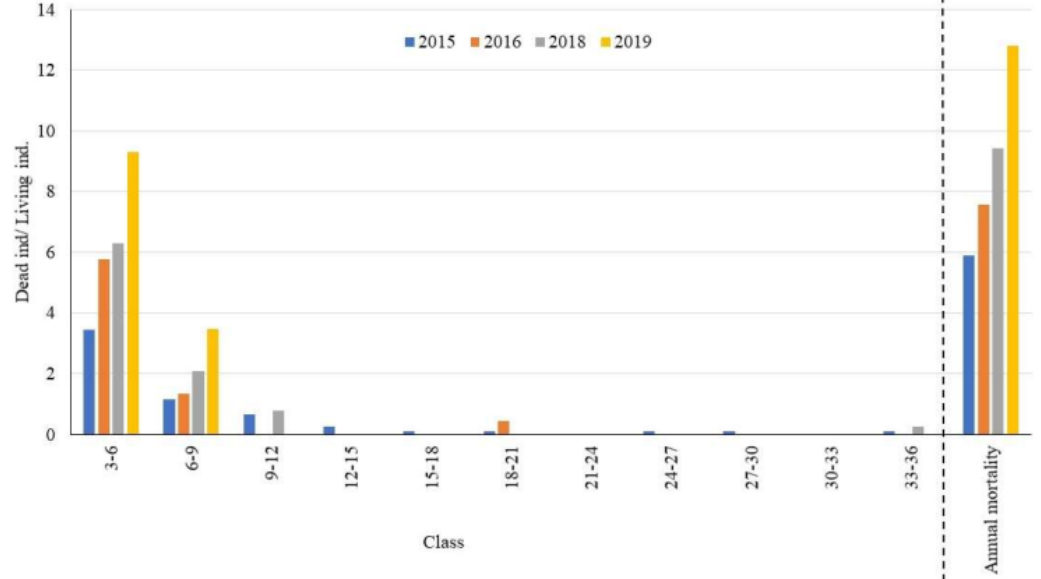
Figure 5. Annual mortality proportion of individuals from the fragment of Dry Tropical Forest in the Caatinga Phytogeographic Domain (DTF/CPD).